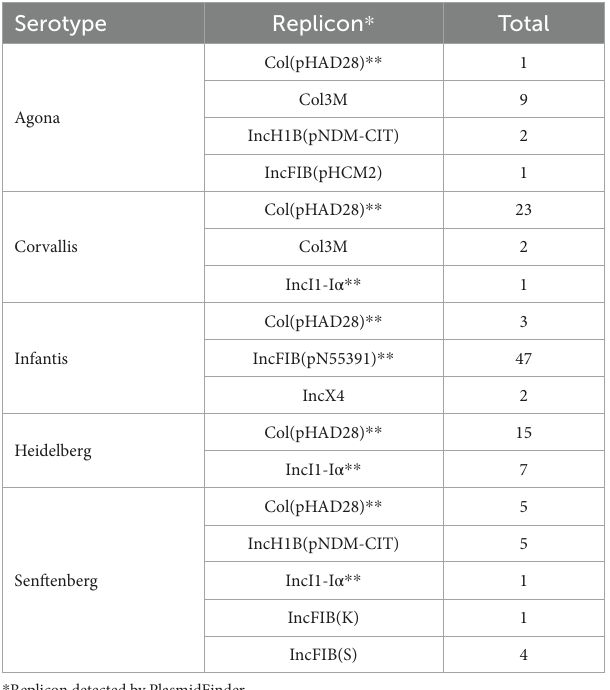
TABLE 3 Antibiotic classes and resistant genes identified in Salmonella isolates.